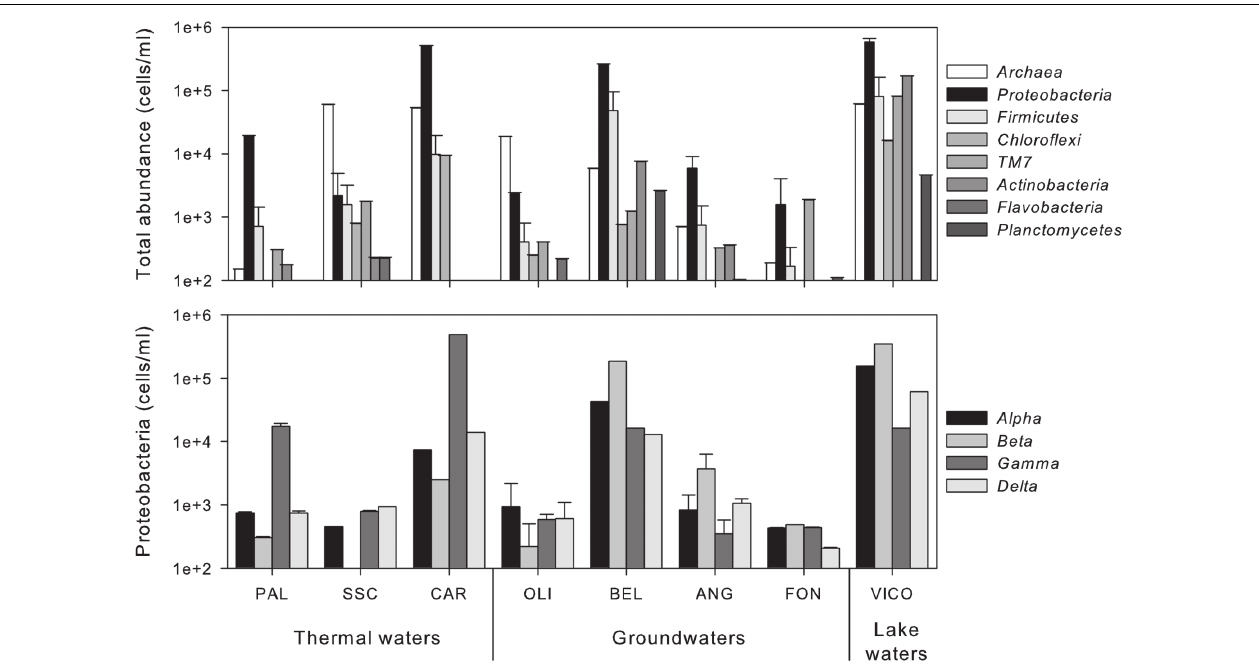
FIGURE 2 | Abundance of phylogenetic clusters ( Archaea and main phyla within Bacteria ) (upper) and single classes within Proteobacteria (lower) in thermal waters, groundwaters and lake